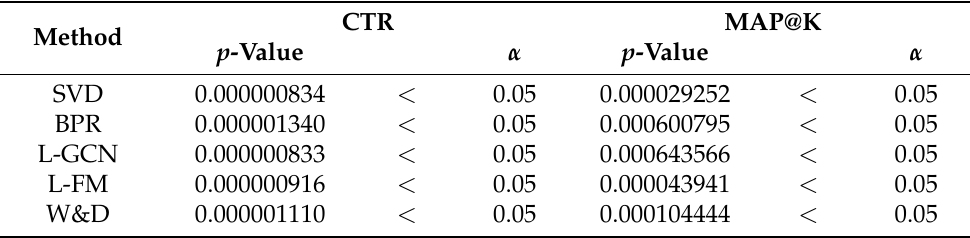
Table 5. The Wilcoxon test of the A/B experiments on the Amazon